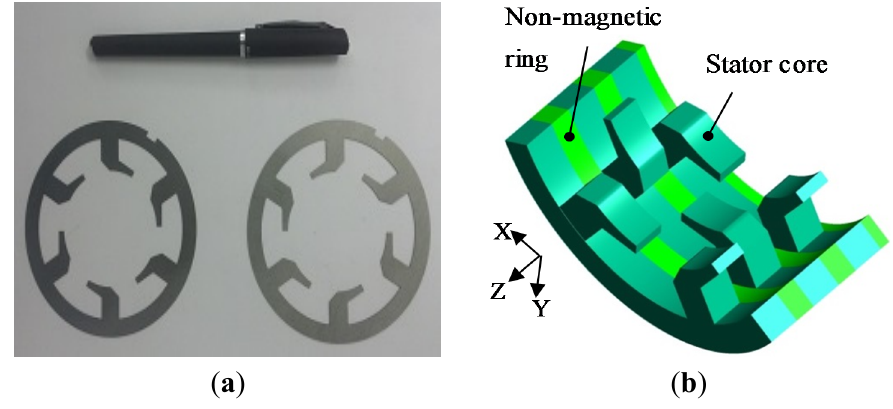
Figure 1. Schematic diagram of the transverse-flux permanent-magnet linear machine (TFPMLM). PM: permanent magnet.